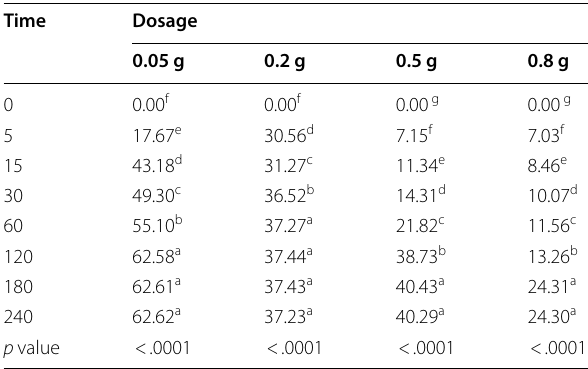
Table 3 Copper removal efficiency under different dosages (0.05–0.08 g) The letters difference a-g indicate the level of significant differences in copper removal efficiencies at varied dosage (p<0.0001).